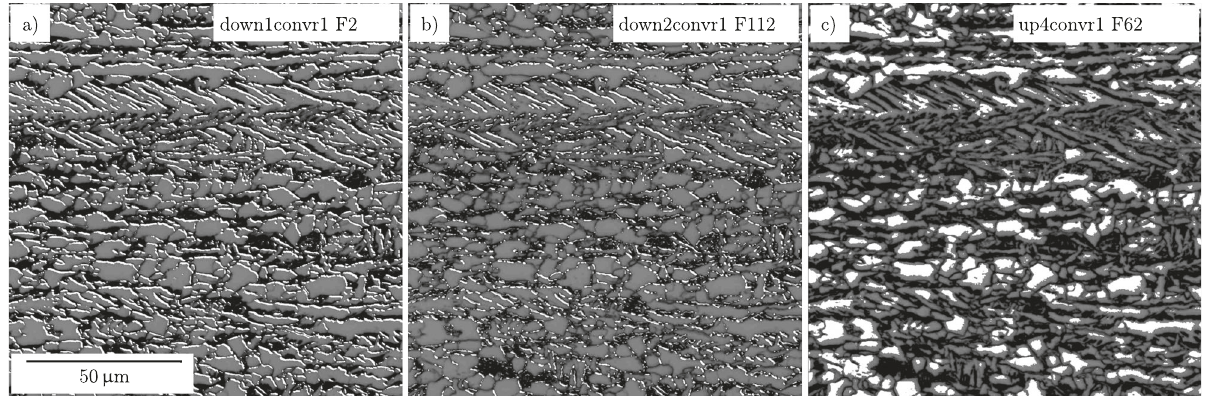
Fig. 6 Thresholded activation maps of speci fi c convolution fi lters using the NetDissect method. a – c Illustrate different relevant extracted features. The high gray value regions indicate disentangled concepts that were learned in experiment #1. Panel legends state the layer, designated in Supplementary Fig. 1, and fi lter numbers (FX) of